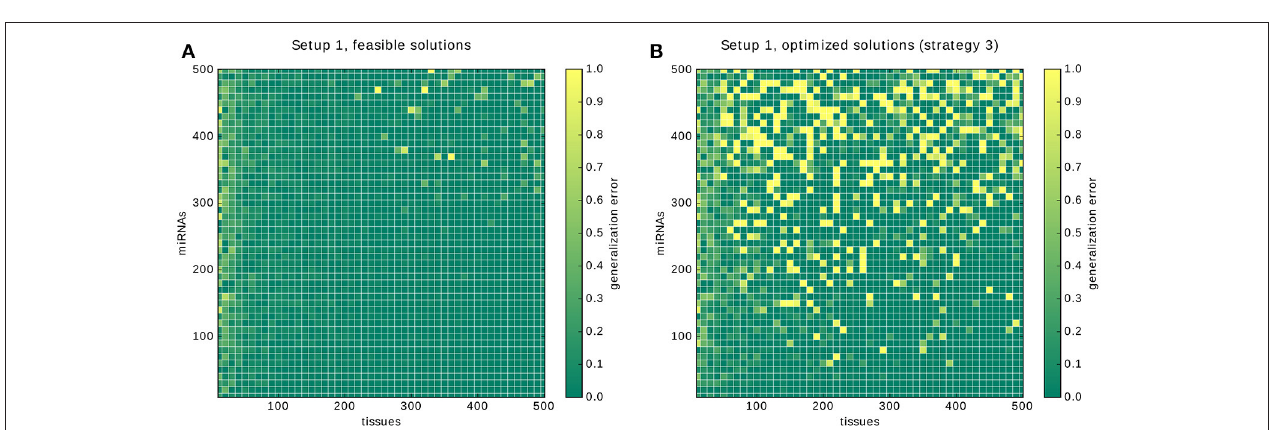
FIGURE 11 | Results of the scalability test. The plot is a benchmark for 50 sampels and miRNAs that range between 50 and 10,000 with a time-out of 30 min. (A) is a scatter plot of the problems that could be solved within the time-limit for Setups 1. The red line and bars show the mean and standard deviation. (B) is a histogram of the number of problems that were timed-out.